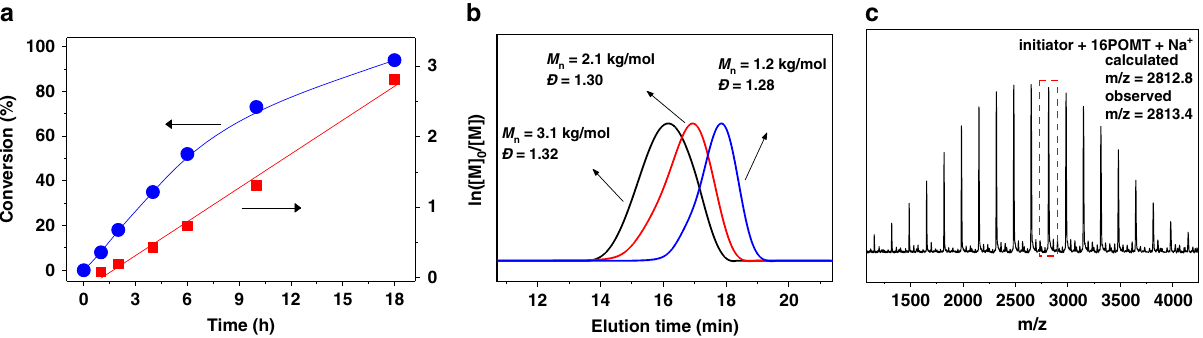
Fig. 2 Polymerization of 2 ˗ (phenoxymethyl) thiirane (POMT) using rhodanine as the initiator. a Monomer conversion and ln([M] 0 /[M]) versus polymerization time. b SEC curves for resulting cyclic polymer at different conversions. c MALDI ˗ TOF MS spectrum of the resulting cyclic polymer.